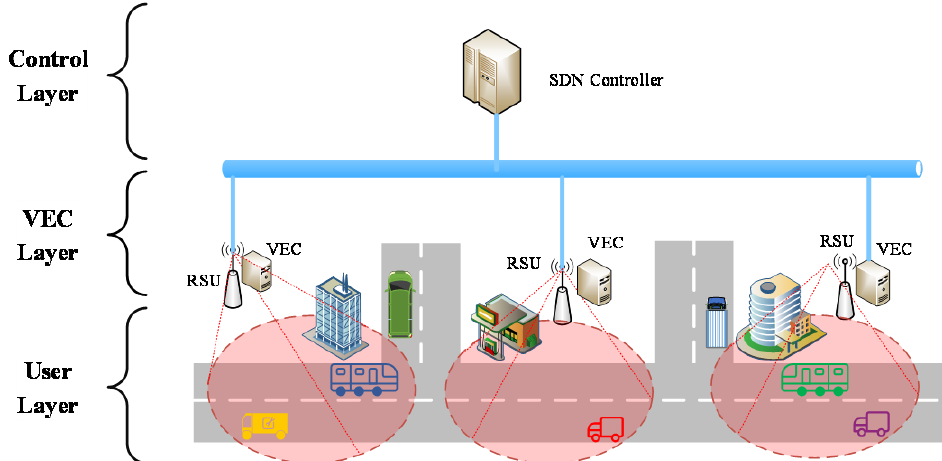
Figure 3. Software-defined vehicular edge networking (SD - VEC) networking layer architecture . Table 1 . Description of the symbols. Symbols